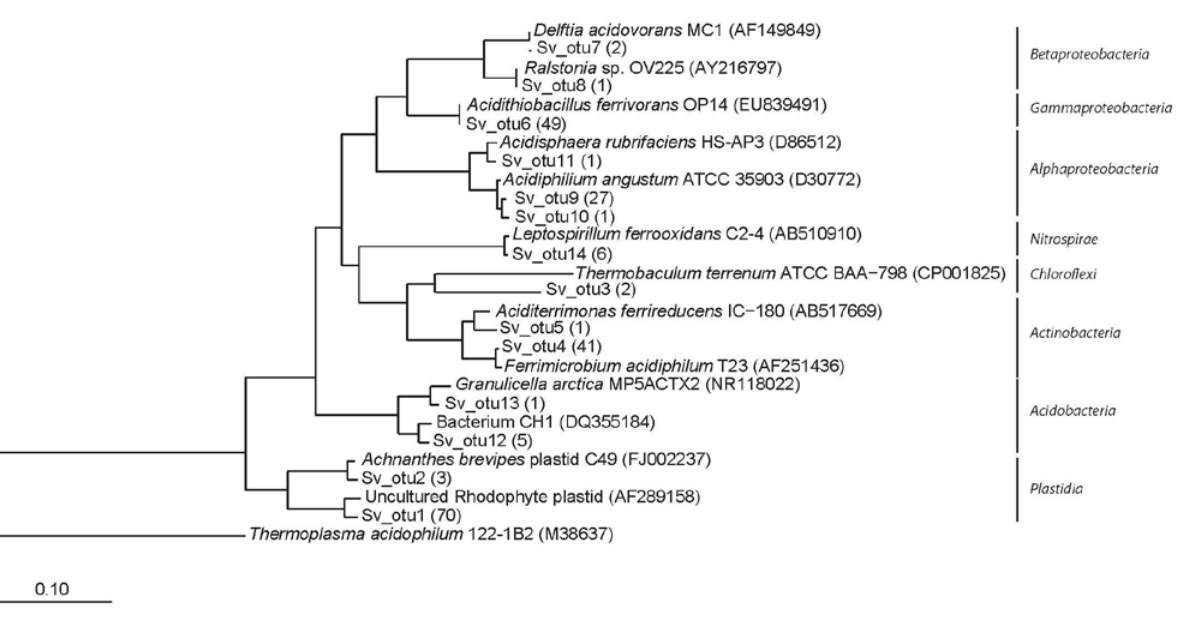
Figure A1. Phylogenetic affiliation for the 16S rRNA gene sequences obtained from the Sverdrup library (Sv). Representative clones for different phylotypes from mat and sediment were selected. A maximum parsimony tree was chosen as a consensus tree after reconstructing the phylogeny by using different algorithms, substitutions models, and filters. Related isolates or environmental sequences are shown for comparison purposes. Bar represents 10% estimated phylogenetic